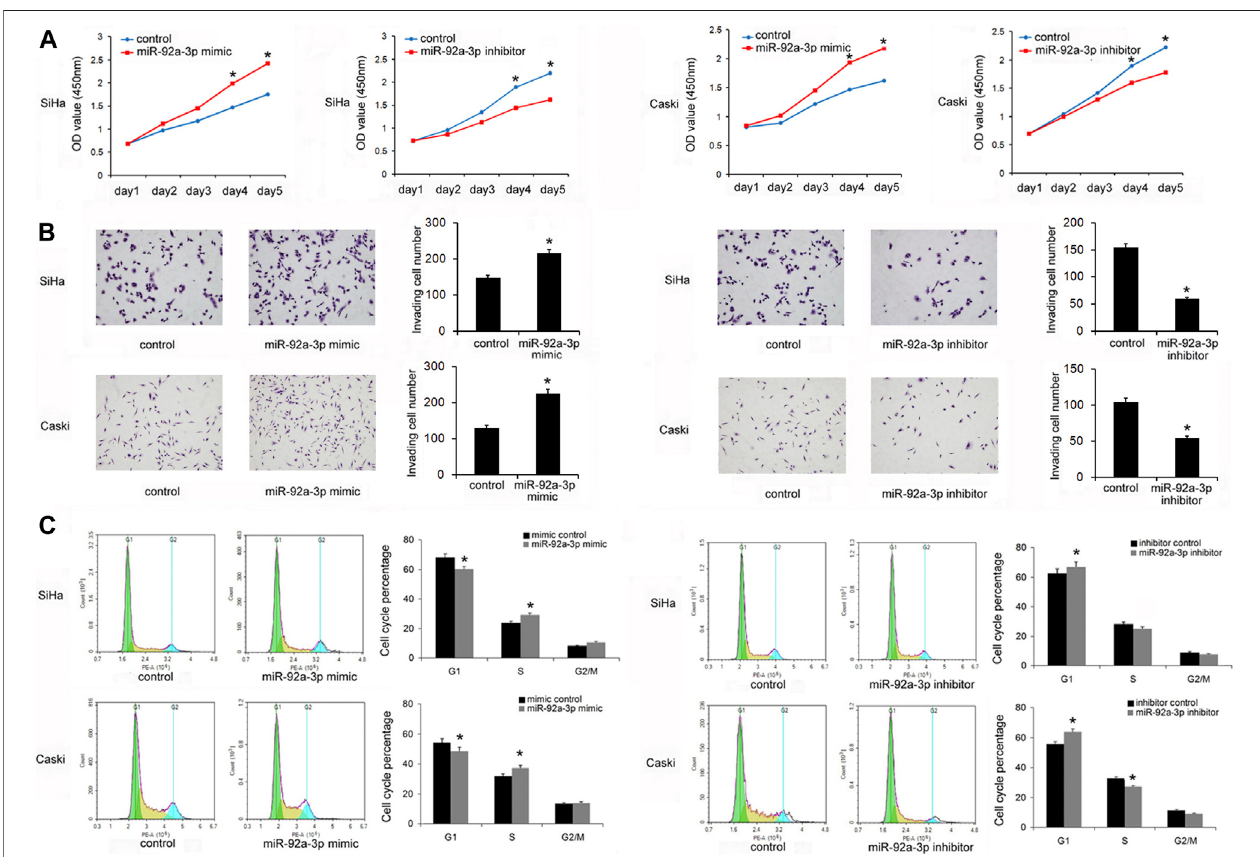
FIGURE 2 | miR-92a-3p promoted proliferation, invasion, and cell cycle transition in cervical cancer stem cells. (A) The Cell Counting Kit-8 assay showed that cell growth in SiHa and Caski cells was increased after transfection of the miR-92a-3p mimic. The cell growth was decreased in SiHa and Caski cells transfected with the miR-92a-3p inhibitor. (B) The Transwell invasion assay showed that the invading number increased after miR-92a-3p overexpression in SiHa and Caski cells. miR-92a- 3p inhibitor transfection decreased the invading SiHa and Caski cell numbers. (C) Flow cytometry results showed that the G1 percentage decreased, and the S percentage increased in SiHa and Caski cells after miR-92a-3p overexpression. miR-92a-3p inhibition increased the percentage of cells in G1 phase and reduced the percentage of cells in S phase. * p < 0.05.